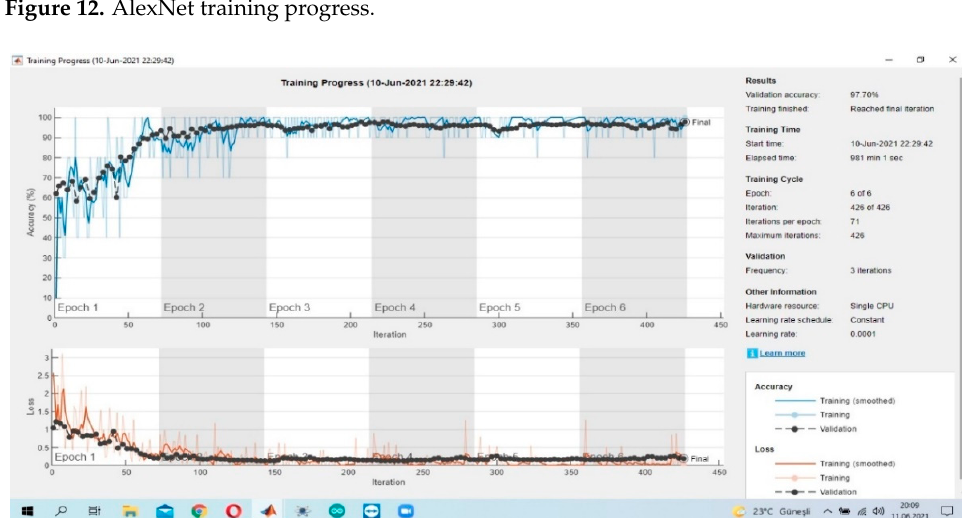
Figure 13. VGGNet training progress.